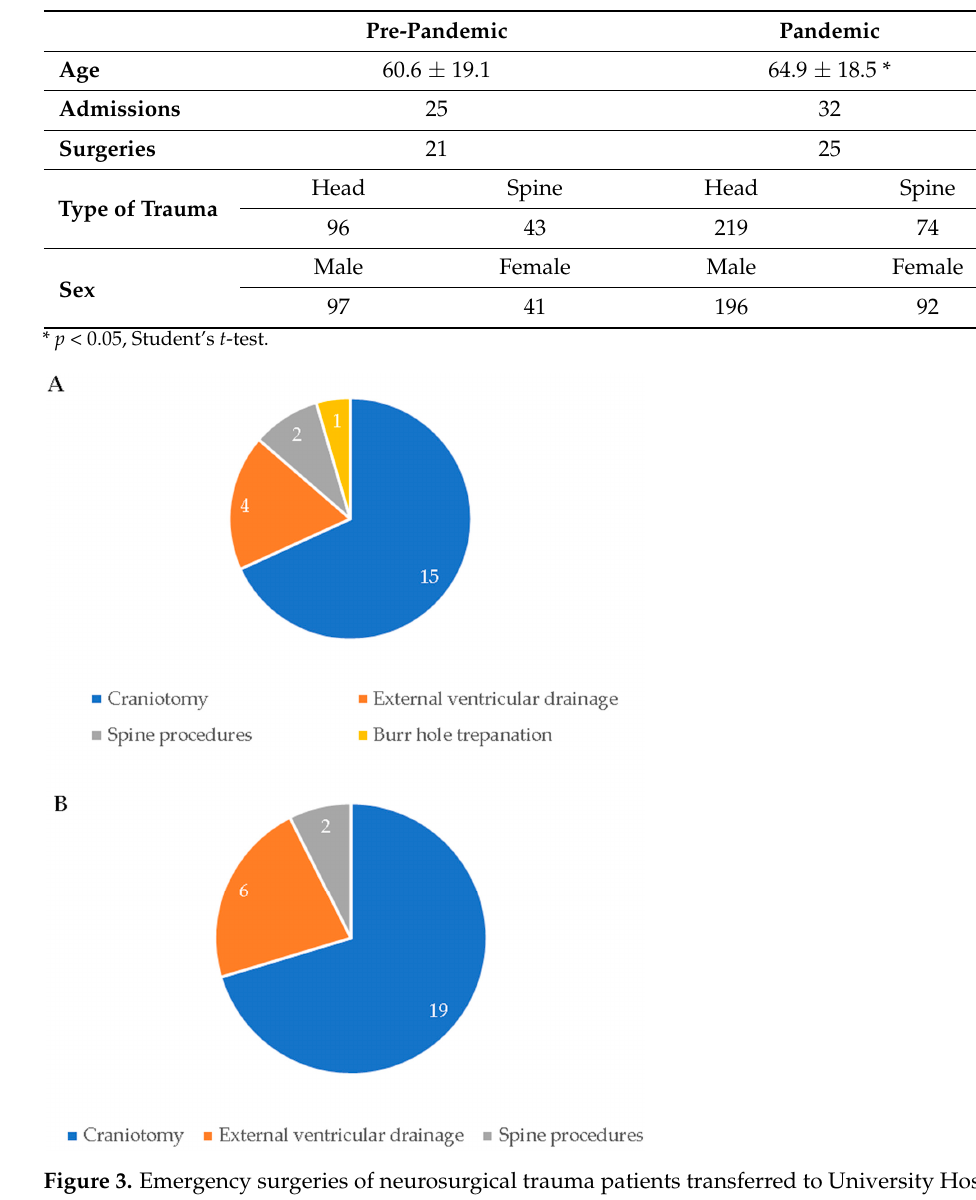
Table 2. Trauma-related consults during pre-pandemic and pandemic periods.